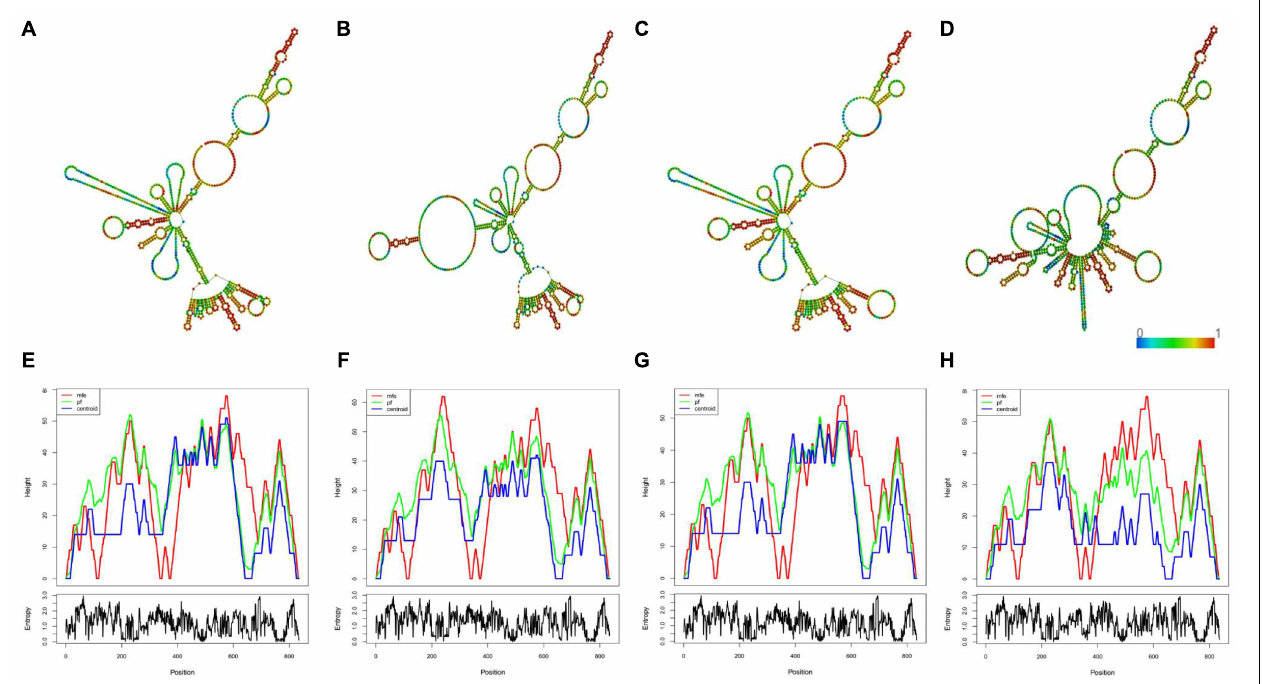
FIGURE 4 | In silico prediction of the candidate SNPs on linc00312 folding structure. (A) The local centroid secondary structure of the wild type linc00312. (B) The local centroid secondary structure of rs12497104 mutant linc00312. (C) The local centroid secondary structure of rs15734 mutant linc00312. (D) The local centroid secondary structure of rs164966 mutant linc00312. The color of each base represents base-pair probabilities. (E) The mountain plot of the wild type linc00312. (F) The mountain plot of rs12497104 mutant linc00312. (G) The mountain plot of rs15734 mutant linc00312. (H) The mountain plot of rs164966 mutant linc00312. The mountain plot presents the MFE structure, the thermodynamic ensemble of RNA structures, the centroid structure and the positional entropy for each position. All of the results were computed by RNAfold